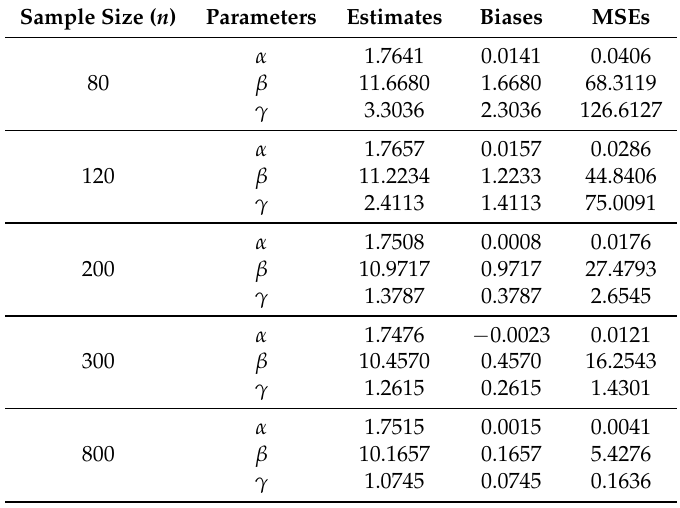
Table 5. Average MLEs, biases and MSEs for α = 1.75 , β = 10 and γ =